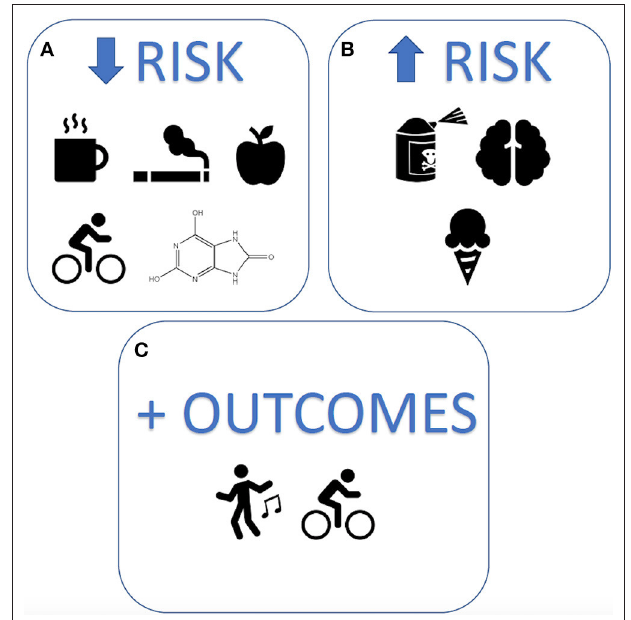
FIGURE 1 | Modifiable lifestyle factors associated with Parkinson’s disease risk and outcomes. The strongest lifestyle factors associated with Parkinson’s disease, reported to date, include (A) reduced risk: caffeine, smoking, uric acid, quality diets, and exercise (B) increased risk: exposure to pesticides, head injury, and dairy products, and (C) improved outcomes: mind-body exercises and physical activity.